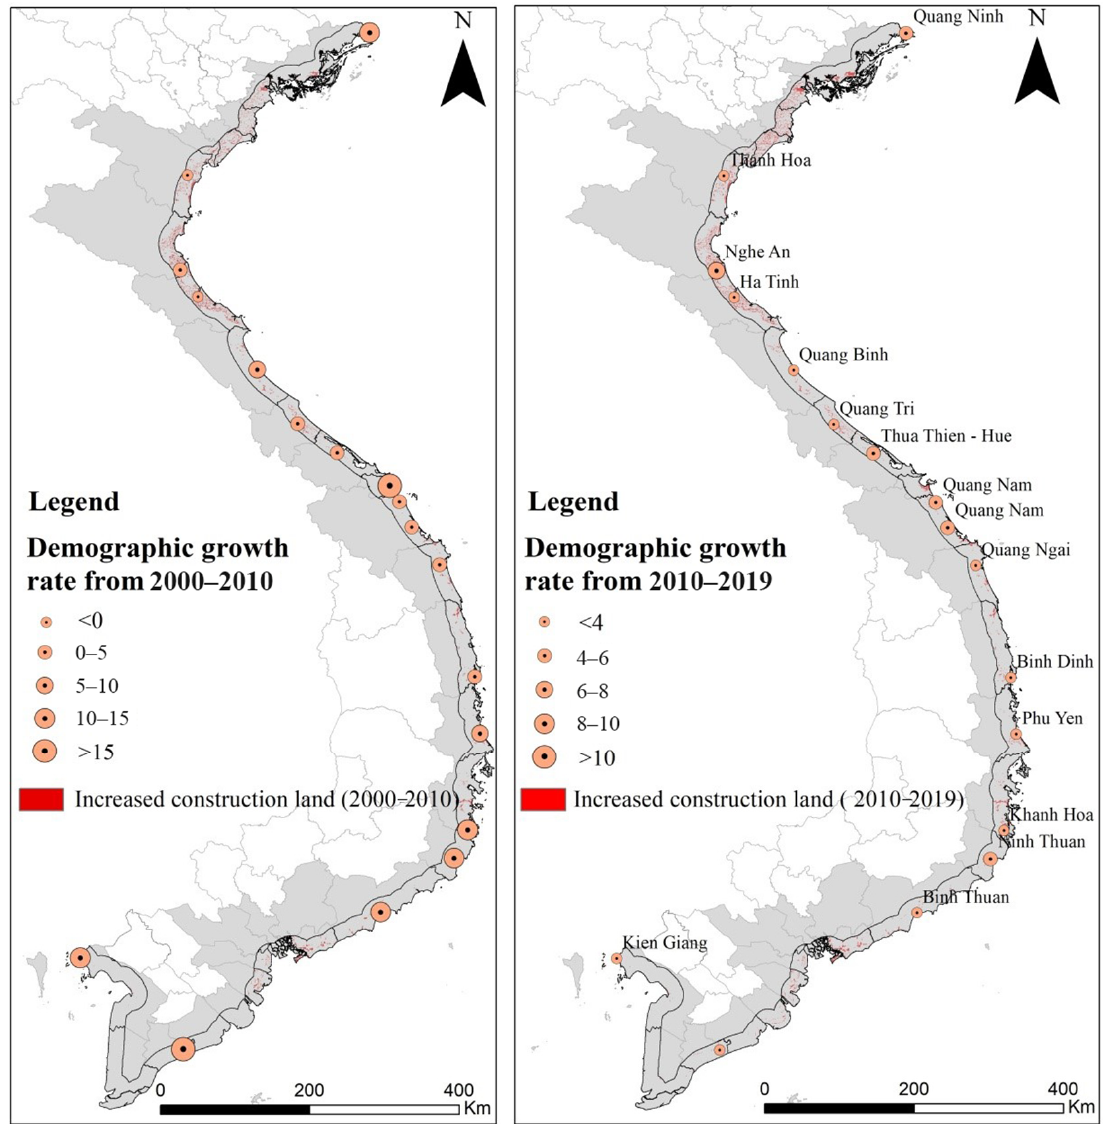
Figure 8. Relationship between population growth and expansion of construction land.